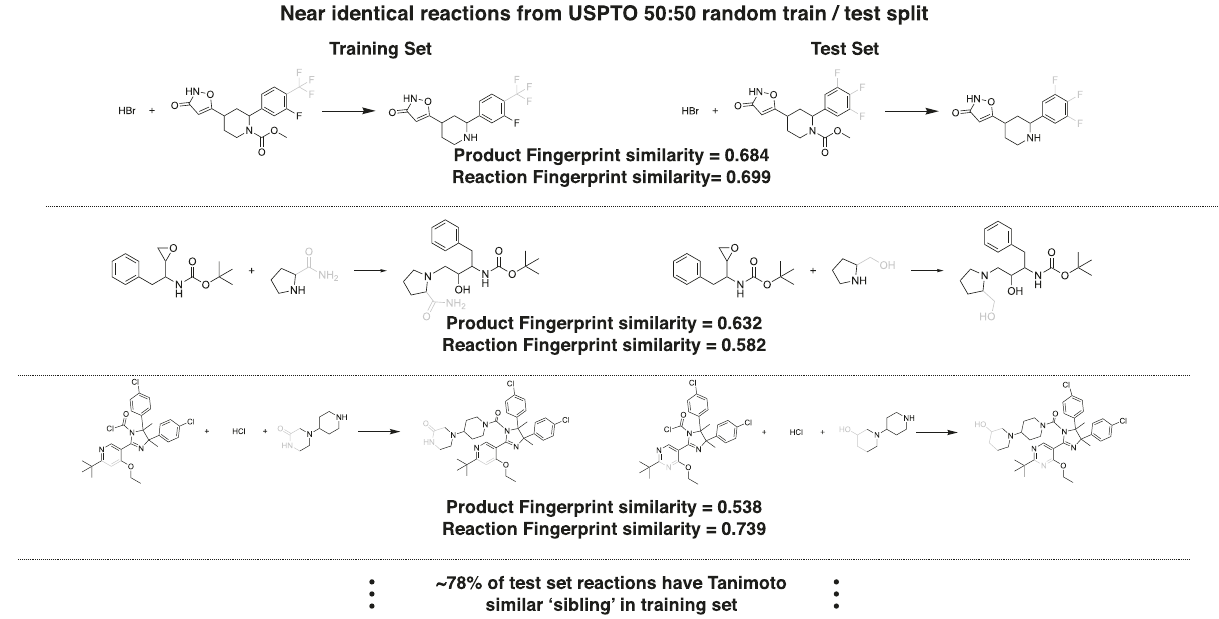
Fig. 6 Near-identical training and testing reactions during random splitting of the dataset. Randomly splitting USPTO results in a large number of near- identical reactions shared between train/test sets. 78% of reactions in the test set have products that are within Tanimoto similarity 0.5 of a product in the training set following a 50:50 random split. By eye, it can be seen that many reactions with similar products (differences are highlighted by shading) have similar reagents and follow near-identical reaction mechanisms. This intuition is con fi rmed by the similarly high similarity of the reaction difference fi ngerprints from the reactions. The equivalent proportions are 93% and 57% for Tanimoto similarity >0.4 and >0.6, respectively. Table 1 Evaluation of reaction prediction models on different train-test splits.